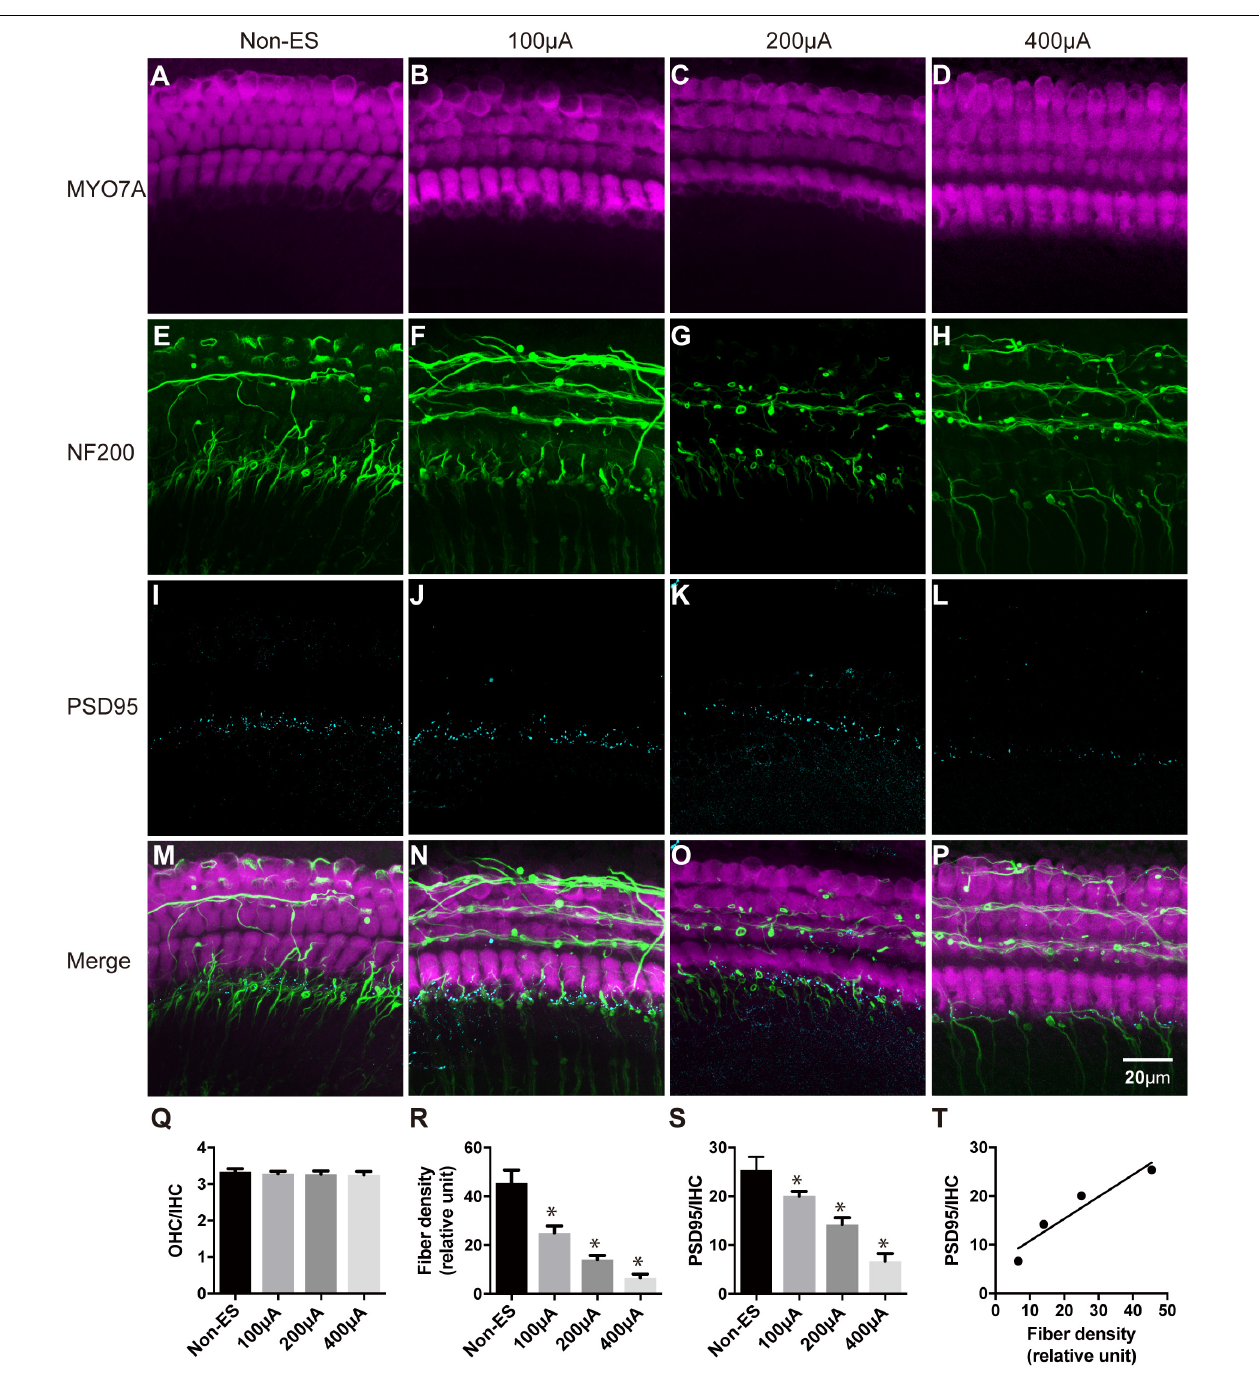
FIGURE 4 | The density of SGN peripheral fibers and the quantity of IHC synapses were synchronously decreased with increasing ES intensity. The quantity and morphology of hair cells (in magenta) were comparable in explants treated with non-ES, 100 µ A ES, 200 µ A ES or 400 µ A ES for 48 h ( A–D ; P = 0.6957, P = 0.5289, P = 0.3364, compared with non-ES in panel Q , one-way ANOVA followed by Dunnett’s multiple comparisons test, the following comparisons in this paper used the same method unless otherwise noted, n = 5 in each group). The density of SGN peripheral fibers (in green) in explants treated with 100, 200, and 400 µ A ES for 48 h was significantly less than that in non-ES explants ( E–H ; ∗ in panel R , P = 0.0001 when compared to non-ES, n = 20 in each group). The PSD95/IHC ratio in explants treated with 100, 200, and 400 µ A ES for 48 h was also significantly less than that in non-ES explants ( I–L ; ∗ in panel S , P = 0.0001 when compared to non-ES, n = 20 in each group). (M–P) The merged images of the upper three images under the same conditions, respectively. (T) There was a significant correlation between the change of SGN peripheral fiber density and the PSD95-punch/IHC ratio with the increase of ES intensity (Pearson test, r = 0.9538, P = 0.0462). Data represent the mean + SEM.